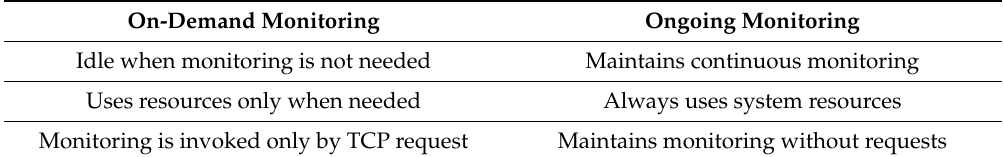
Table 3. Comparison between on-demand and ongoing monitoring.